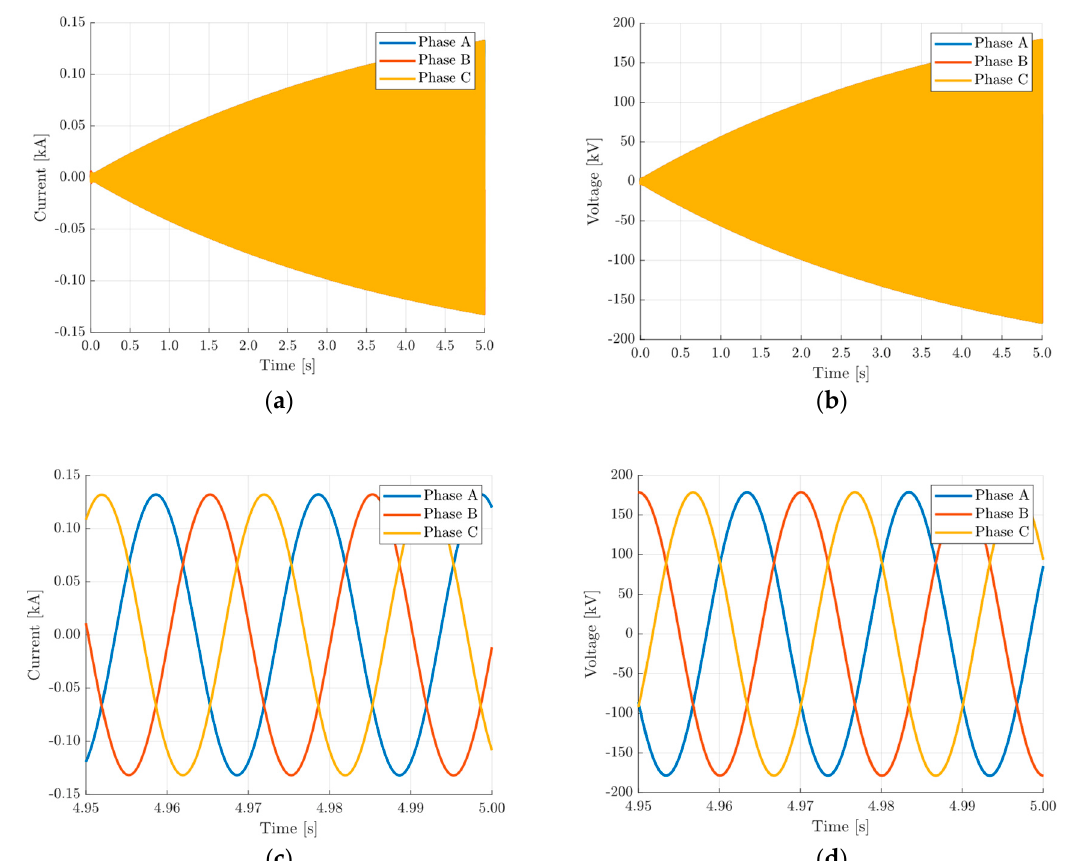
Figure 8. Current ( a ) and voltage ( b ) waveforms with a synchronous generator as the self-start unit in the simplified benchmark system applying soft-charge, with current ( c ) and voltage ( d ) zoomed waveforms that show that there are no distortions.